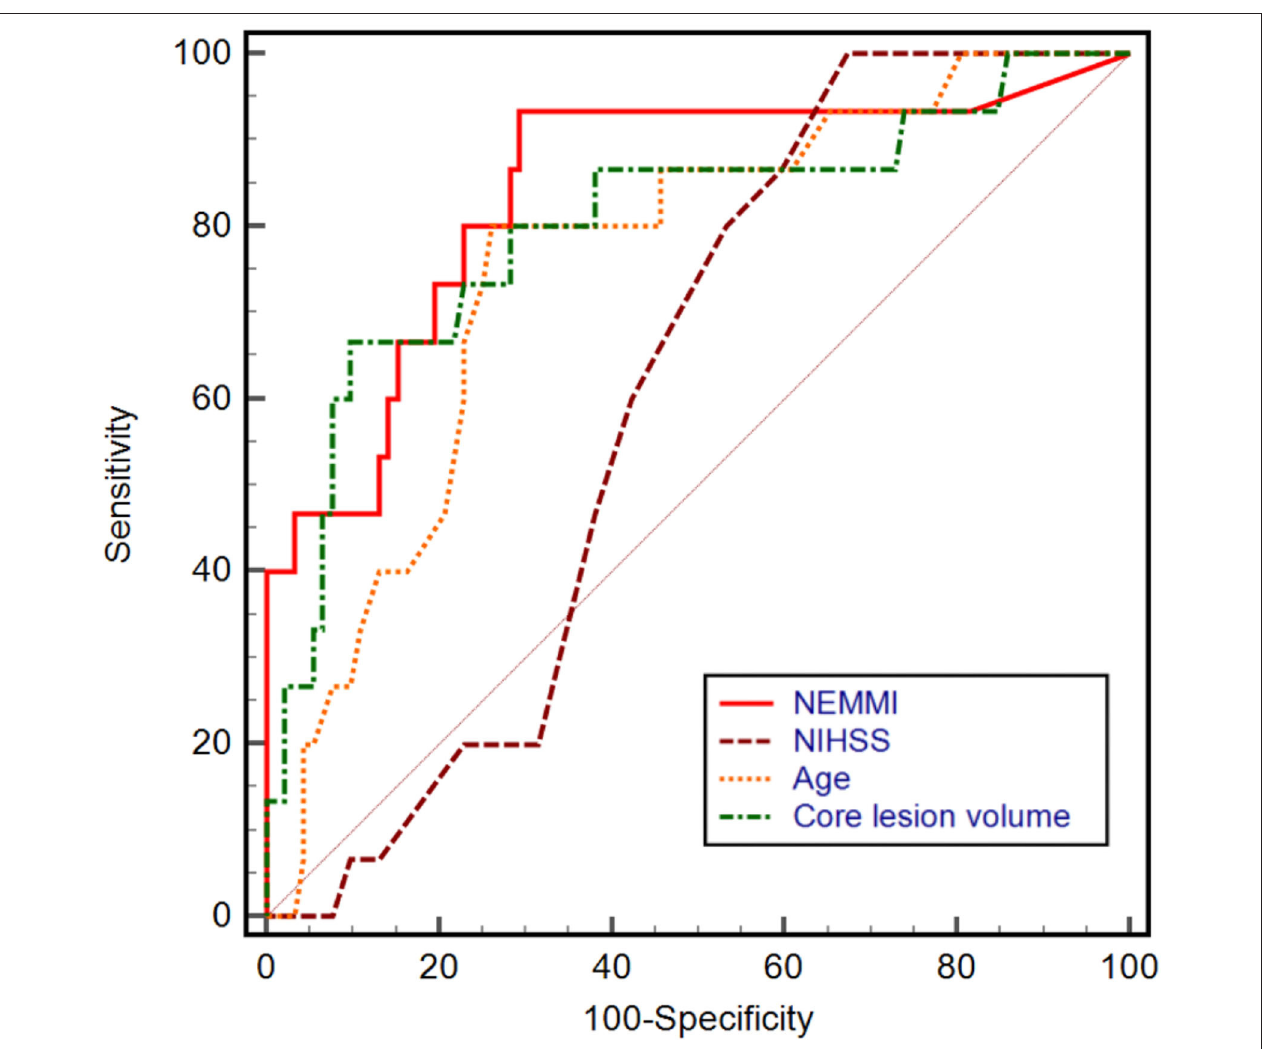
FIGURE 4 | Univariable receiver operating characteristic (ROC) curves with the corresponding area under the curve (AUC) of NEMMI score, admission National Institute of Health Stroke Scale (NIHSS) score, age, and core lesion volume in CT-perfusion. The power to discriminate between subsequent non-malignant and malignant infarction was highest for a NEMMI score > 10.5 (AUC: 0.84, sensitivity: 93.3%, specificity: 70.7%, Youden J: 0.64), followed by core lesion volume (AUC: 0.80), age (AUC: 0.76), and NIHSS (AUC: